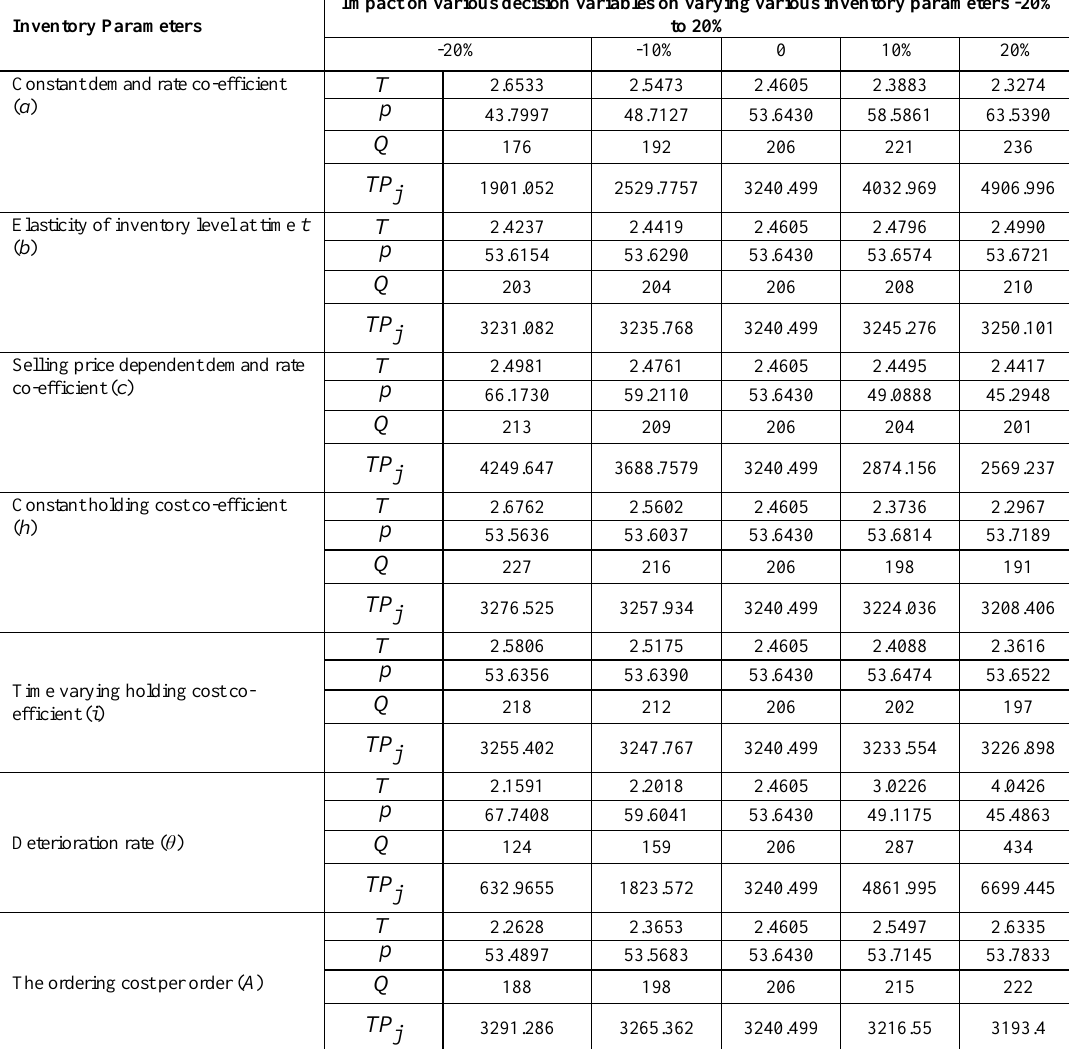
Table 1. Impact on various decision variables on varying various inventory parameters Inventory